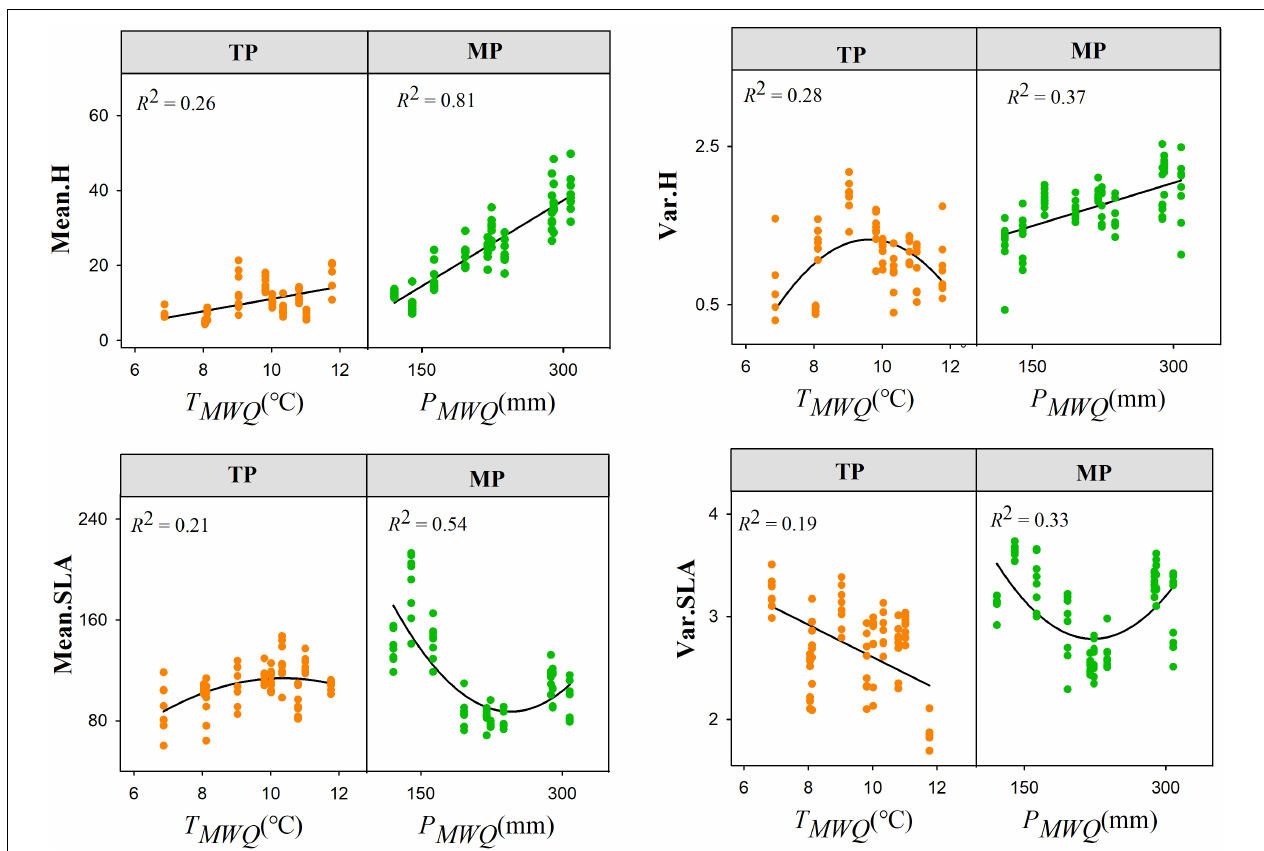
FIGURE 2 | Shifts in the trait frequency distributions for height (H) and specific leaf area (SLA) within grassland communities along environmental gradients. Mean.H and Mean.SLA represent community-weighted mean of height and SLA, respectively; Var.H and Var.SLA represent community-weighted variance of height and SLA,